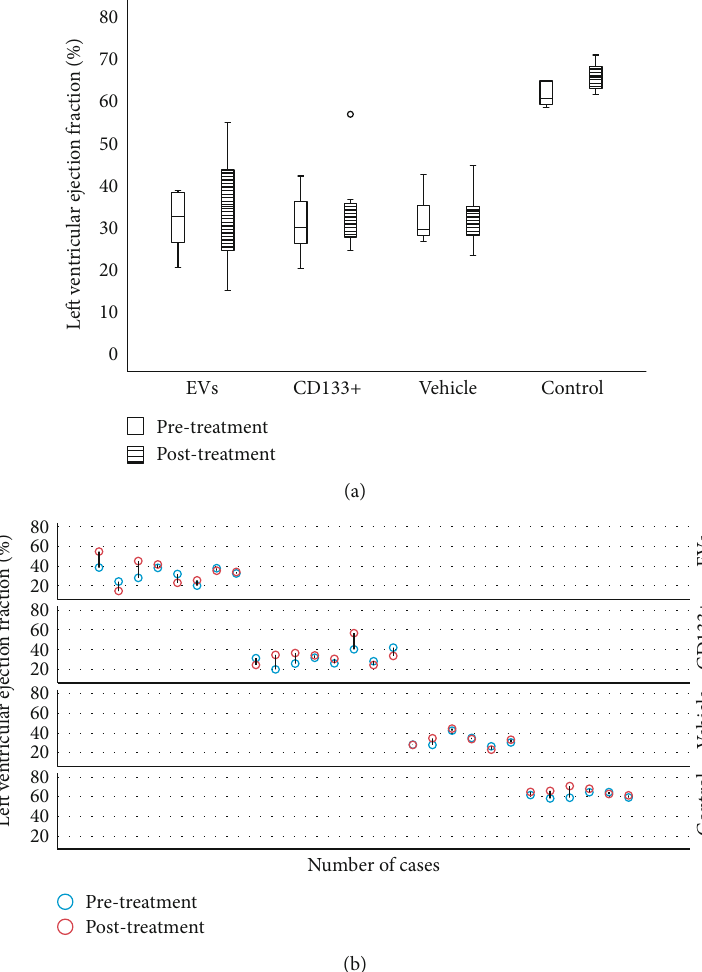
Figure 2: Echocardiographic evaluation of left ventricular ejection fraction. (a) Comparison of the left ventricular ejection fraction within each group before and after transplantation. (b) Left ventricular ejection fraction percentage of each animal pre- (blue circle) and post- (red circle) treatment. Data are presented as median and minimum and maximum values. ° : outlier value; LVEF: left ventricular ejection fraction; EVs: transplanted with expanded CD133 + cell-derived EVs; CD133 + : transplanted with expanded CD133 + cells; vehicle: treated with PBS; control: healthy animals ( n = 6 to 8 per